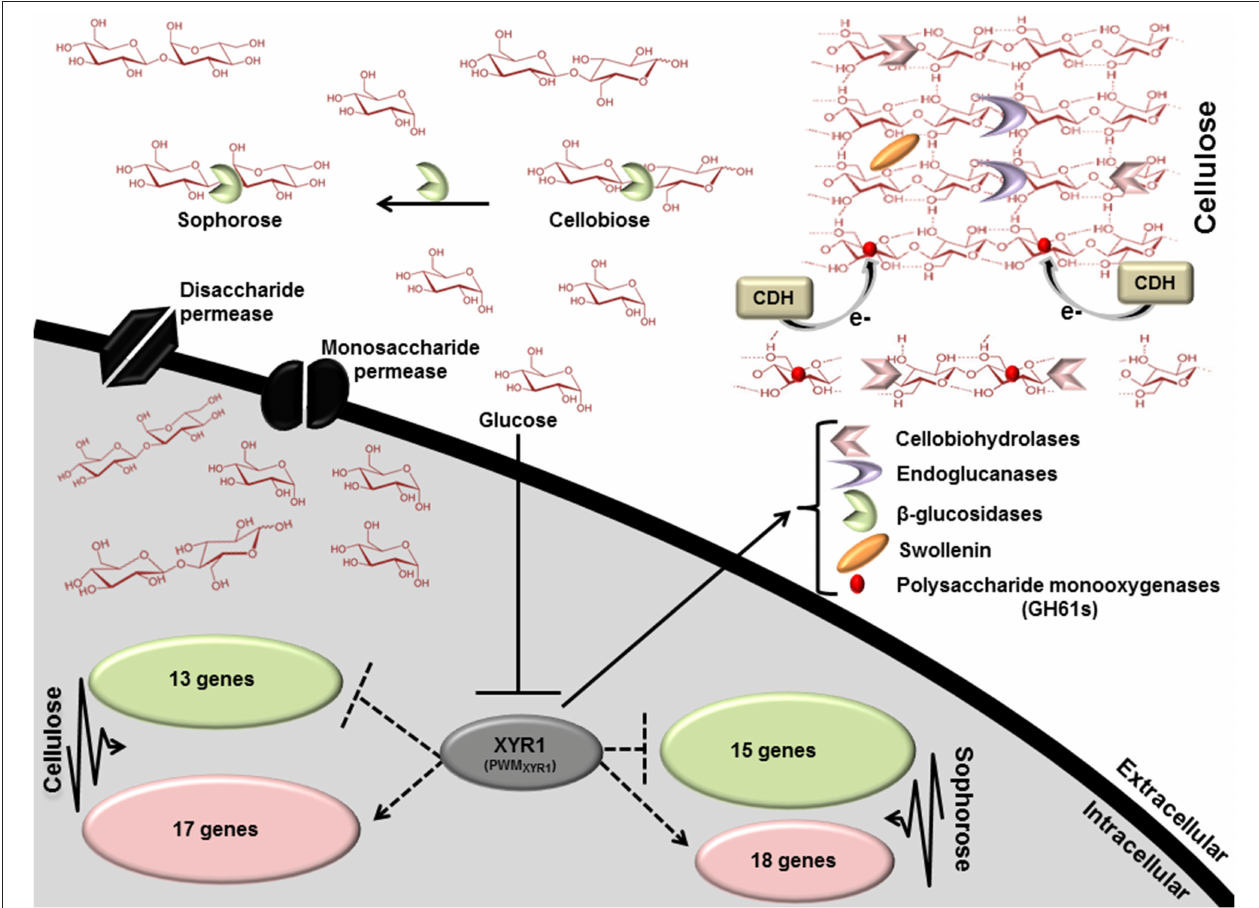
FIGURE 6 | Scheme involving the direct regulation by the Zn2Cys6 transcription regulator XYR1. This figure shows the processes that are expected to be involved in xyr1 regulation of lignocelluosic enzymes in T. reesei . Endoglucanases (EGs) hydrolyze cellulose bonds internally, while cellobiohydrolases cleave cellobiose units from the ends of the polysaccharide chains. The released cellobiose units (disaccharides) are subsequently hydrolyzed by β -glucosidases, releasing glucose, the main carbon source readily metabolisable by T. reesei . Expansin proteins (Swollenin) rapidly induce extension of plant cell walls by weakening the noncovalent interactions that help to maintain their integrity. Cellobiose dehydrogenase (CDH) is a potential electron donor for polysaccharide monooxygenases (PMOs). EGs and PMOs internally cleave cellulose chains releasing chain ends that are targeted by cellobiohydrolases (CBHs). Dotted arrows indicate potential areas of research for enhancement of enzymes secretion in T. reesei : XYR1 activates or represses (directly) the transcription of genes in cellulose and sophorose. PWM XYR1 defined in Silva-Rocha et al.